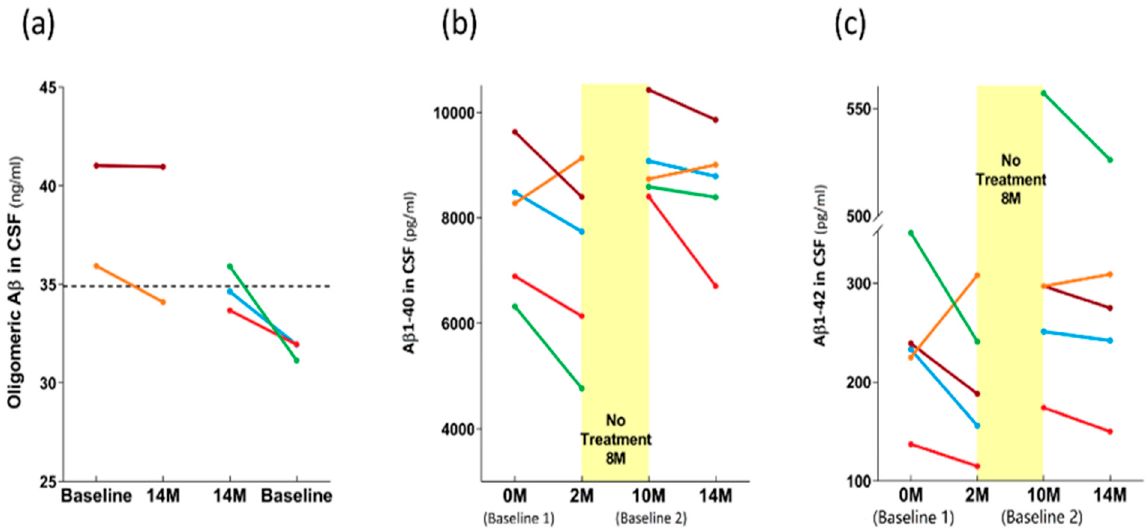
Figure 10. For individual subjects, effects of 14M TEMT on CSF levels of oligomeric A β ( a ), A β 1-40 ( b ), and A β 1-42 ( c ). Each color represents results from the same subject. The effects of TEMT on A β 1-40 and A β 1-42 in CSF are best visualized by evaluating the levels at all four CSF collection points: 0 months (baseline 1), 2M, 10M (baseline 2), and